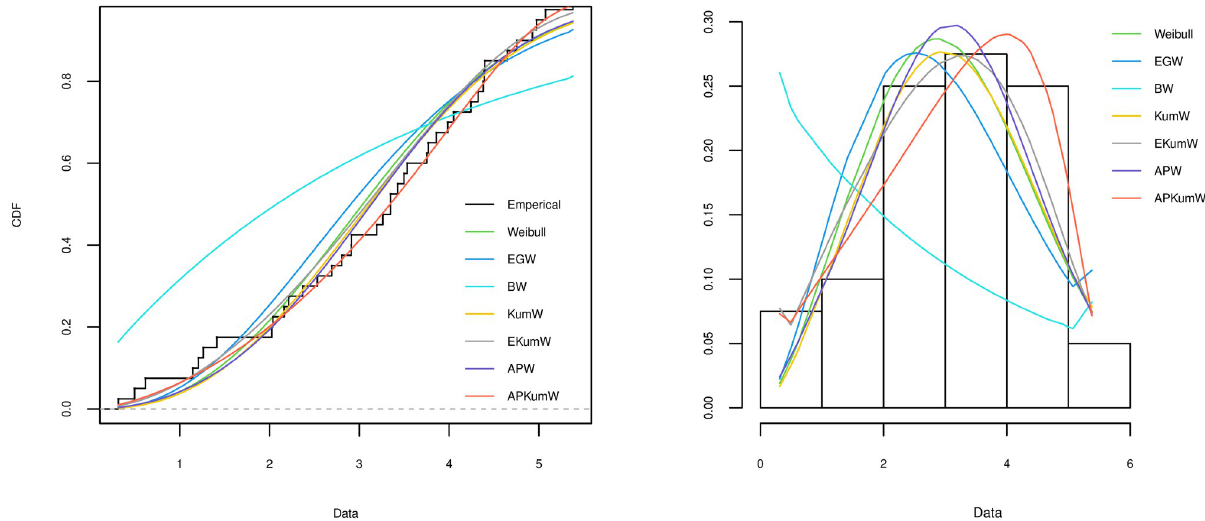
Fig 4. Theoretical and empirical cdf and pdf comparison of the blood cancer